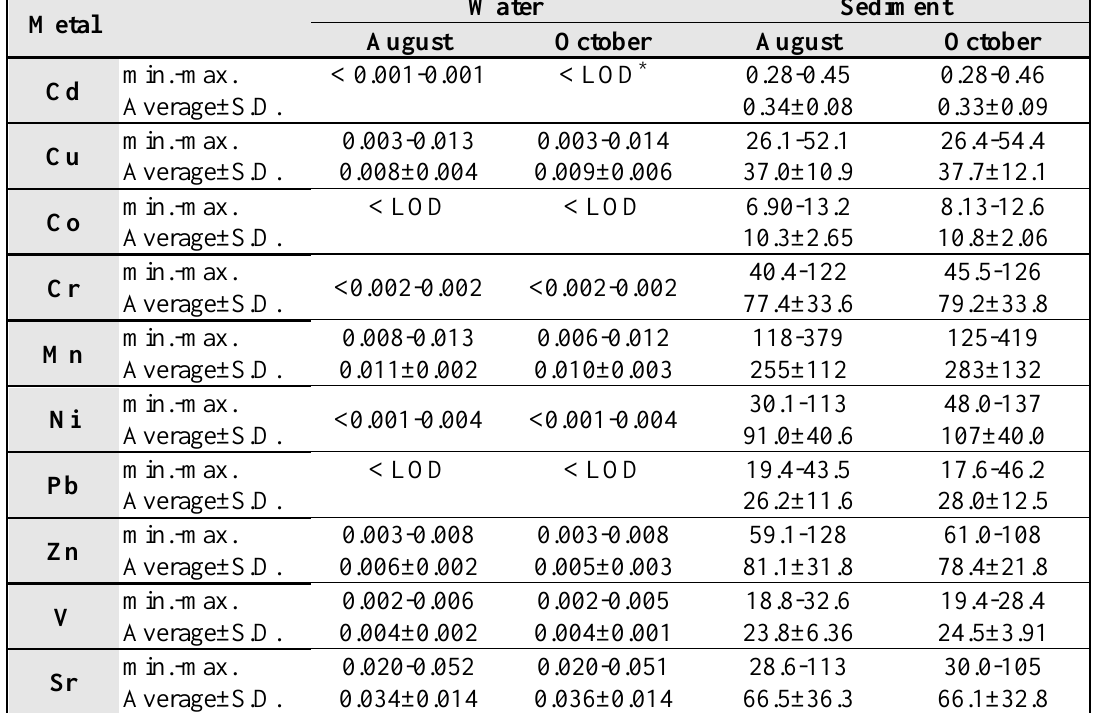
Table 1. – Minimum/maximum and average concentrations (mg/l; mg/kg d.w.dm 3 ) ±